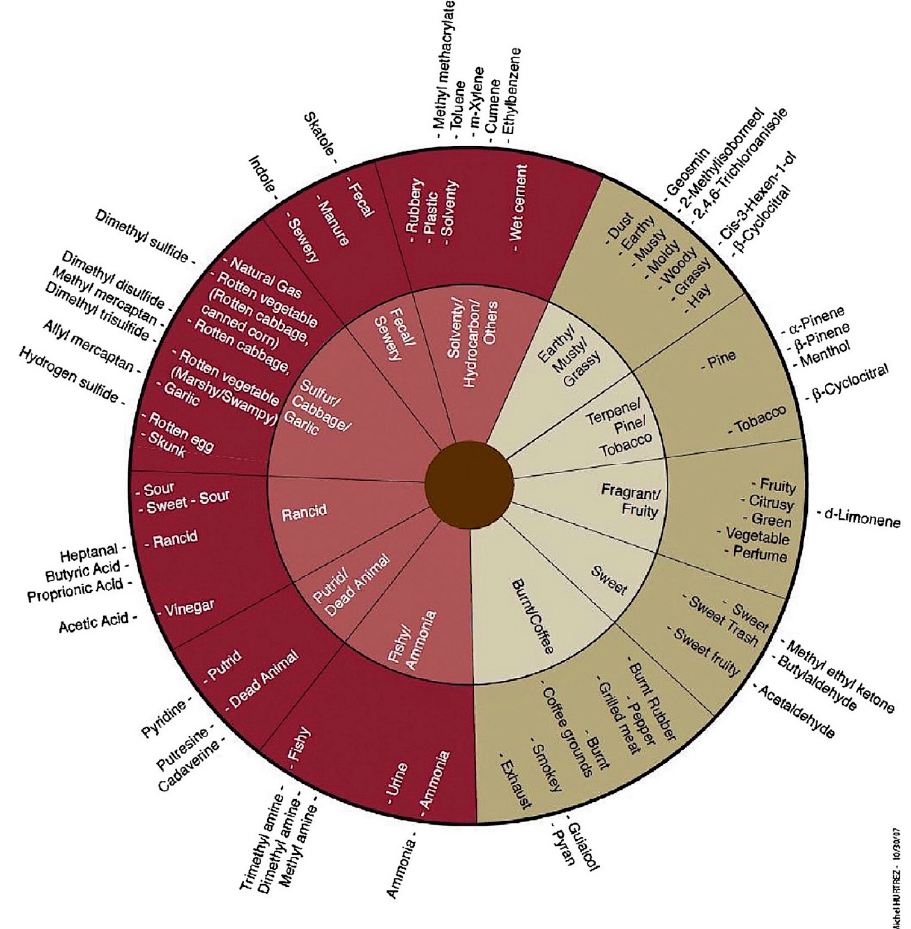
Figure 2. Landfill Odor Wheel [8].